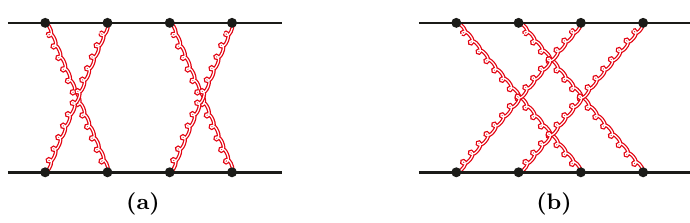
Figure 12. Both the double cross diagram (a) and the saltire diagram (b) are immediately written in terms of colour dipole operators by commuting the pair of Reggeon emission vertices at the end of either the top or of the bottom